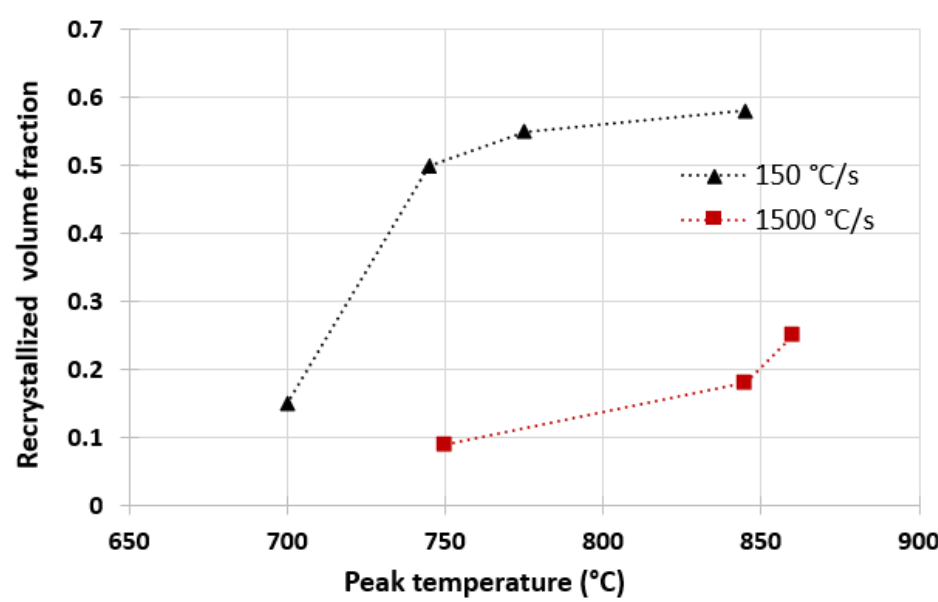
Figure 7. Recrystallized fraction as a function of peak temperature for two different HRs (data from [42]).